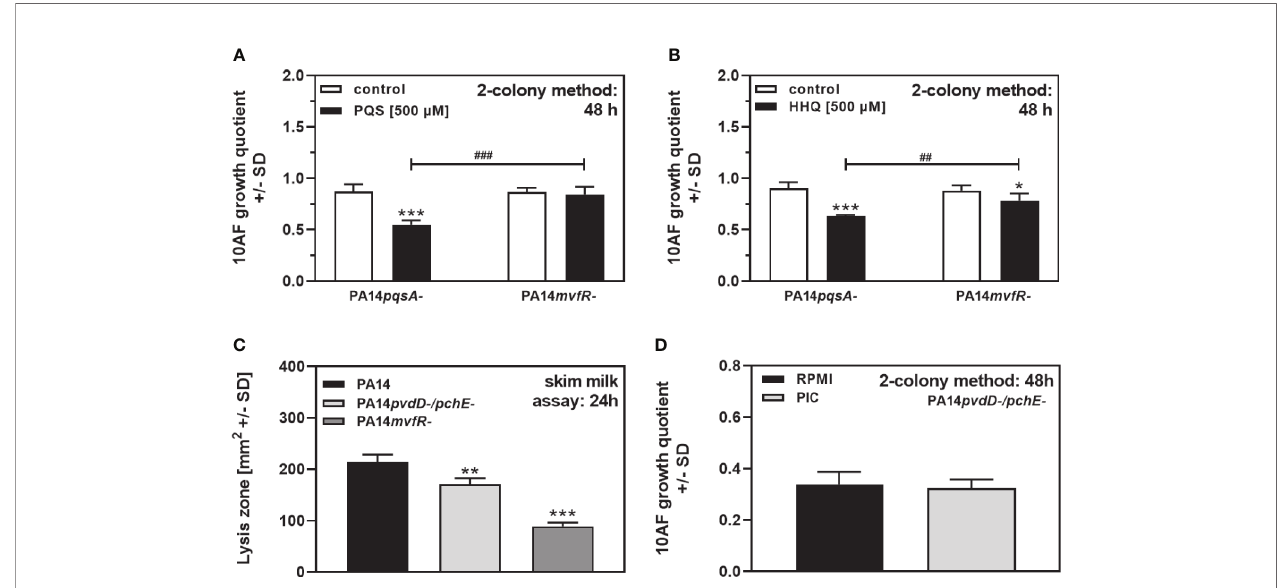
FIGURE 5 | QS-signaling contributes to P. aeruginosa antifungal activity on agar. (A, B) Six-millimeter paper disks were placed on RPMI agar. Ten microliters of A. fumigatus 10AF conidia (10 7 /ml, prepared in RPMI) was placed on each paper disk, and 10 µl of PA14 pqsA- or PA14 mvfR- bacteria (10 9 /ml, prepared in RPMI) was placed 15 mm distant from the disks carrying 10AF. Mutant bacterial suspensions were supplemented with RPMI (white bars), PQS (black bars in A ), or HHQ ( black bars in B ). Plates were incubated for 48 h at 37°C, and growth quotients were determined by the two-colony method. Comparison: RPMI controls vs . all other bars in the same group, or as indicated by the ends of the brackets. (C) Six-millimeter paper disks were placed on RPMI agar, containing 2% skim milk. Ten microliters of PA14, PA14 pvdD-/pchE- , or PA14 mvfR- bacteria (10 9 /ml, prepared in RPMI) was placed on the disks. Plates were incubated for 24 h at 37°C, and lysis zones were determined. Comparison: PA14 wild type vs . all mutants, or as indicated by the ends of the brackets. (D) Six-millimeter paper disks were placed on RPMI agar. Ten microliters of A. fumigatus 10AF conidia (10 7 /ml, prepared in RPMI) was placed on each paper disk, and 10 µl of PA14 pvdD-/pchE- bacteria (10 9 /ml, prepared in RPMI) was placed 15 mm distant from the disks carrying 10AF. Ten microliters of protease inhibitor cocktail (PIC; 1:1000) was added to the bacterial droplets. Plates were incubated at 37°C for 48 h, and growth quotients were determined by the two-colony method. Statistical analysis in (A – D) , t-test: one, two, or three asterisks or pound signs = p ≤ 0.05, p ≤ 0.01, and p ≤ 0.001, respectively. Asterisks represent signi fi cant increases; pound signs represent signi fi cant decreases in antifungal activity (A , B) , or in proteolytic activity (C)